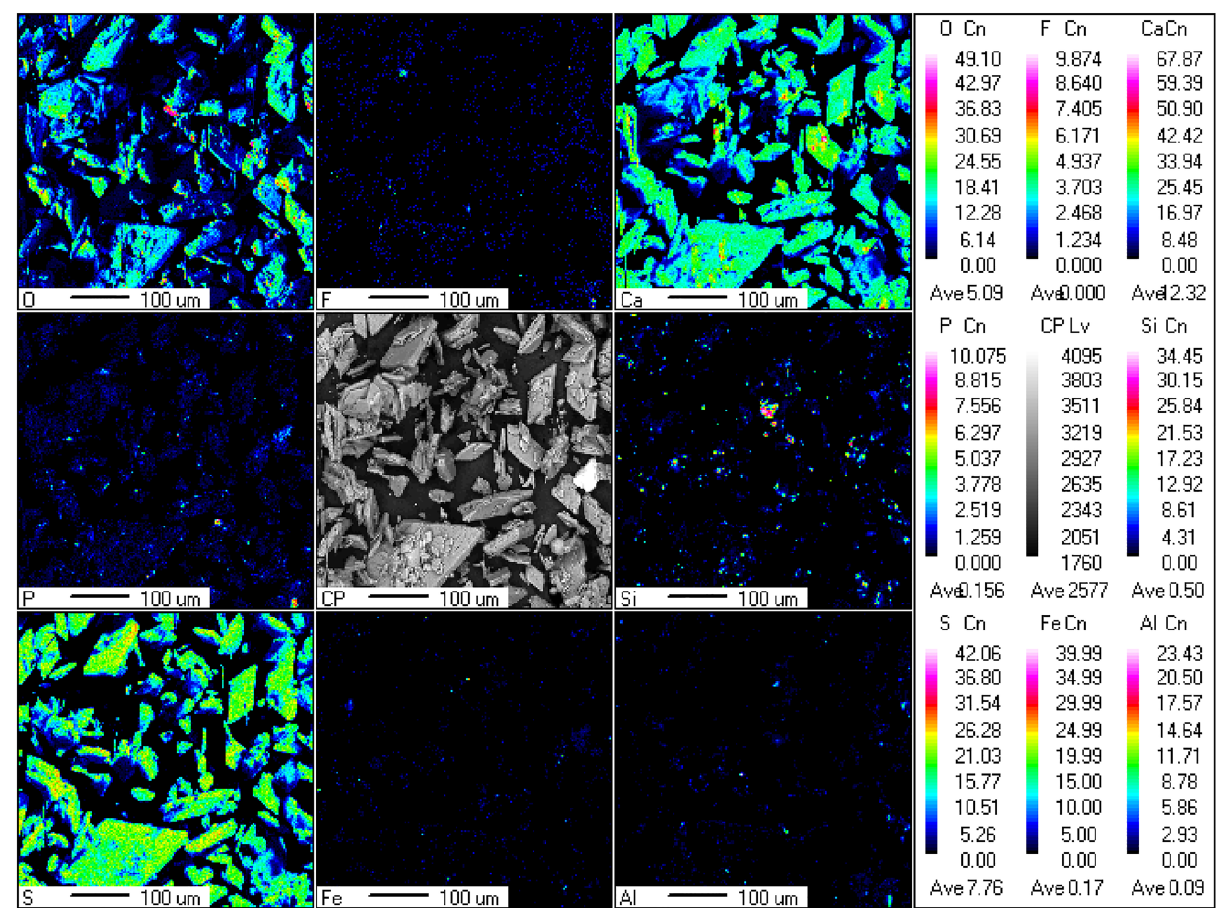
Figure 3. The distribution of Ca, S, O, F, P, Si, Al, and Fe on the surface of PG, as determined by EPMA.